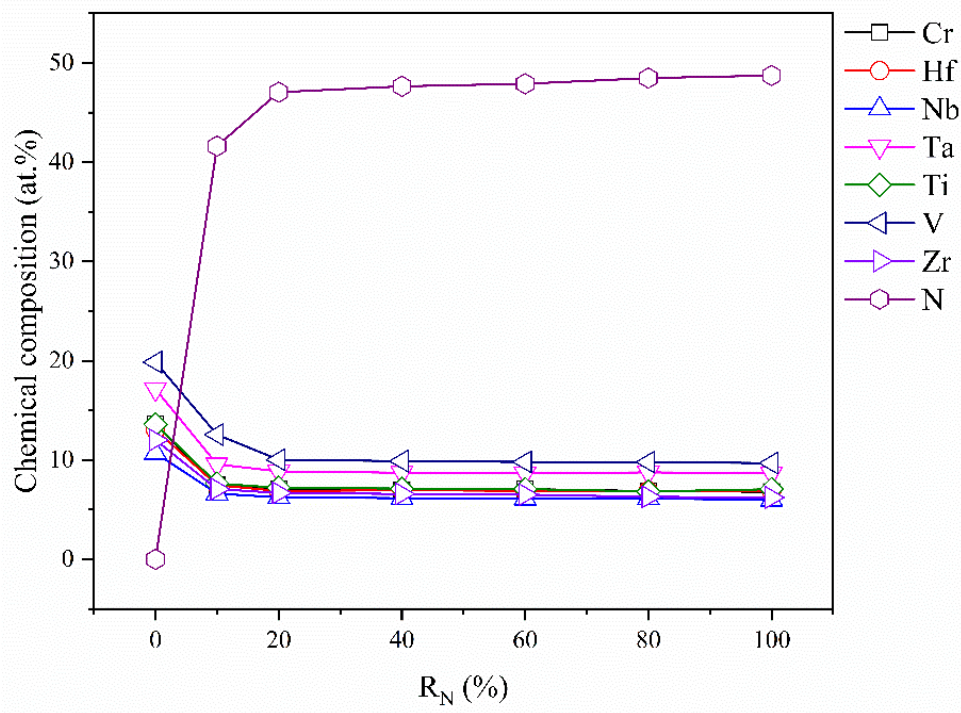
Figure 2. Chemical compositions in (CrHfNbTaTiVZr)N coatings deposited at various R N .